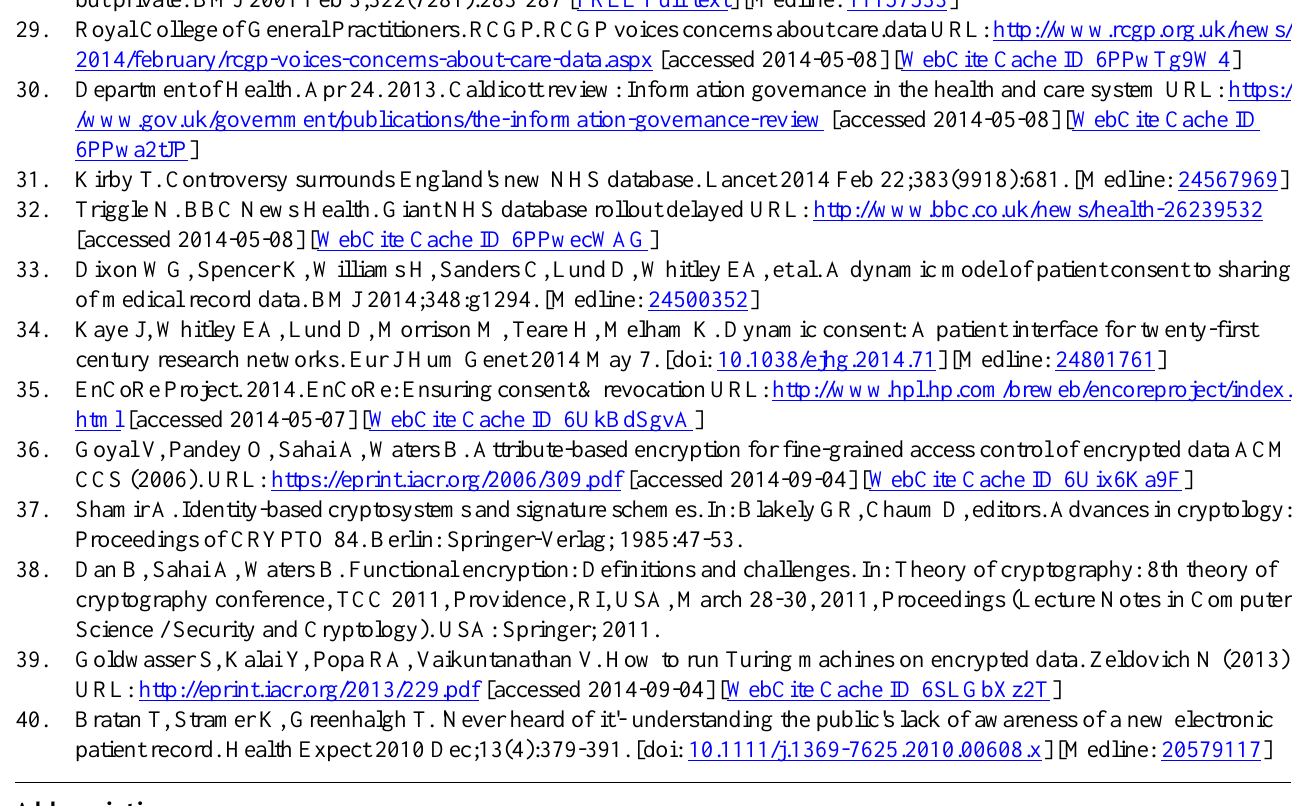
CPRD: Clinical Practice Research